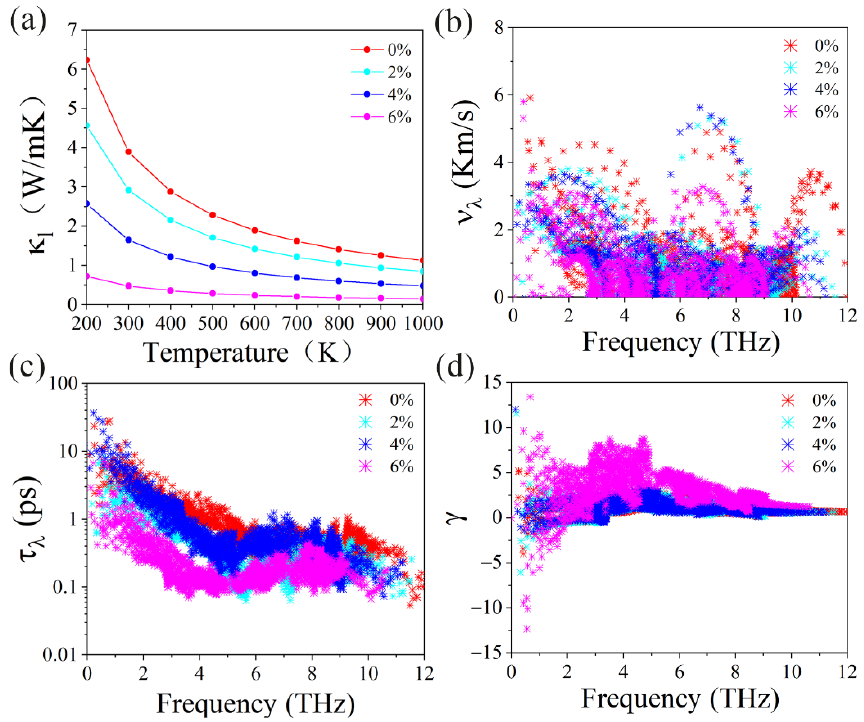
Figure 9. ( a ) The calculated lattice thermal conductivity κ l with respect to temperature under different tensile strains for GeS 2 monolayer. The ( b ) phonon group velocity, ( c ) phonon relaxation time, and ( d ) Grüneisen constants for GeS 2 monolayer at different tensile strains.